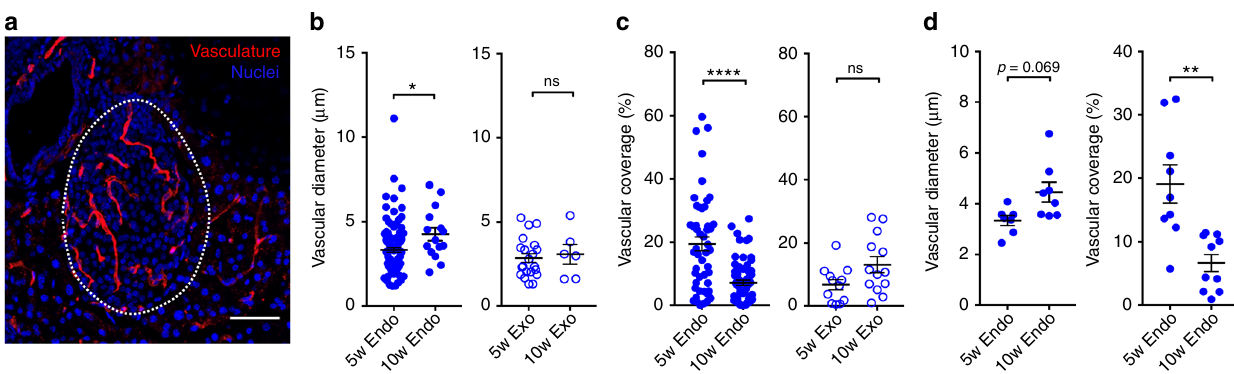
Fig. 4 Changes in islet, but not exocrine microvascular morphology, with age in the pancreata of NOD mice. a Representative maximum-projection confocal image over 10 μ m depth of pancreas section from NOD mouse infused with texas-red labeled tomato lectin (red). Islet is circled with a dotted line, as determined from bright fi eld and DAPI-labeling morphology. b Mean vessel diameter in islet (Endo) and exocrine tissue (Exo) in 5- and 10-week-old NOD female mice. c As in b for vascular coverage. d Data for islet vessel diameter and vascular coverage in b , c plotted by mouse. Scale bar in a represents 100 μ m. Error bars represent s.e.m. * p < 0.05, ** p < 0.01, *** p < 0.001, **** p < 0.0001 comparing groups indicated ( t -test data in b – d ). Data in b represents in total 65 islets (37 islets, at 5w, 28 islets at 10w) and 27 exocrine regions (21 at 5w, 6 at 10w) from 7 NOD mice per time point. Data in c represents in total 112 islets (49 at 5w, 63 at 10w) and 25 exocrine regions (12 at 5w, 13 at 10w) from 9 NOD mice per time